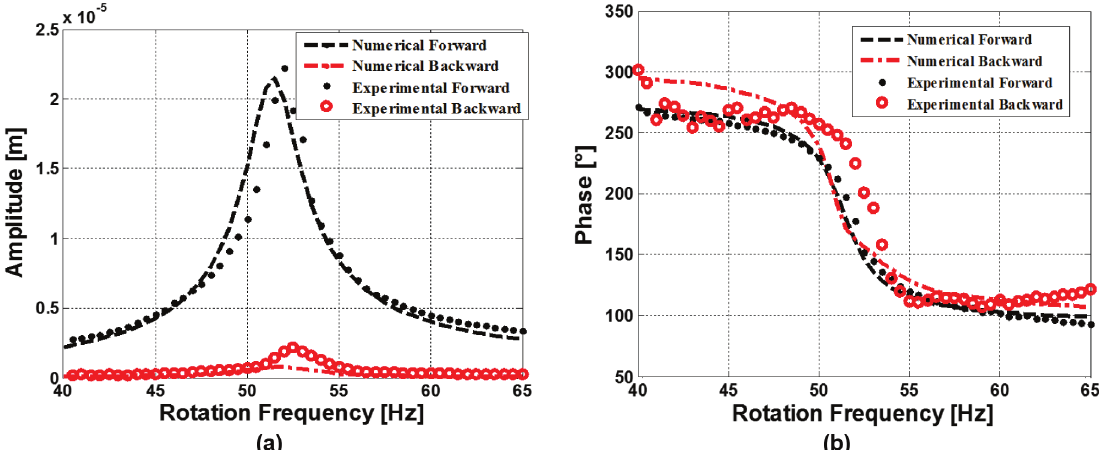
Figure 15 - Directional response of the system (bearing B2 position) for bearings with no wear – a) Amplitude and b) Phase.